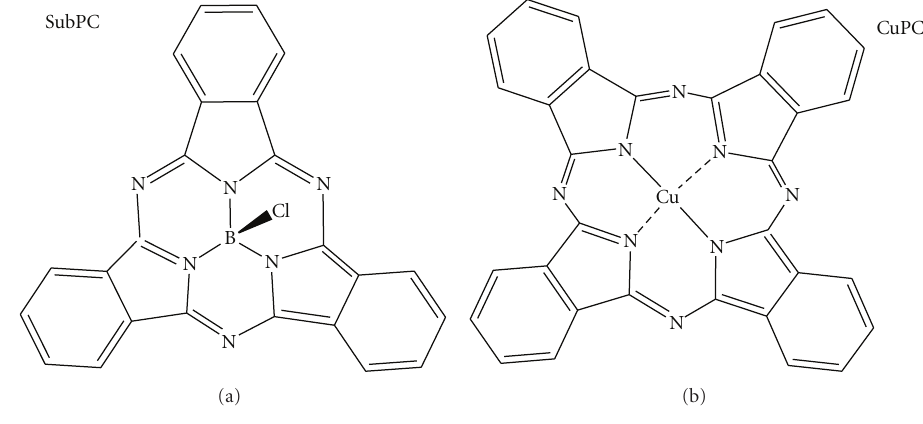
Figure 3: Molecular Structure of SubPC and